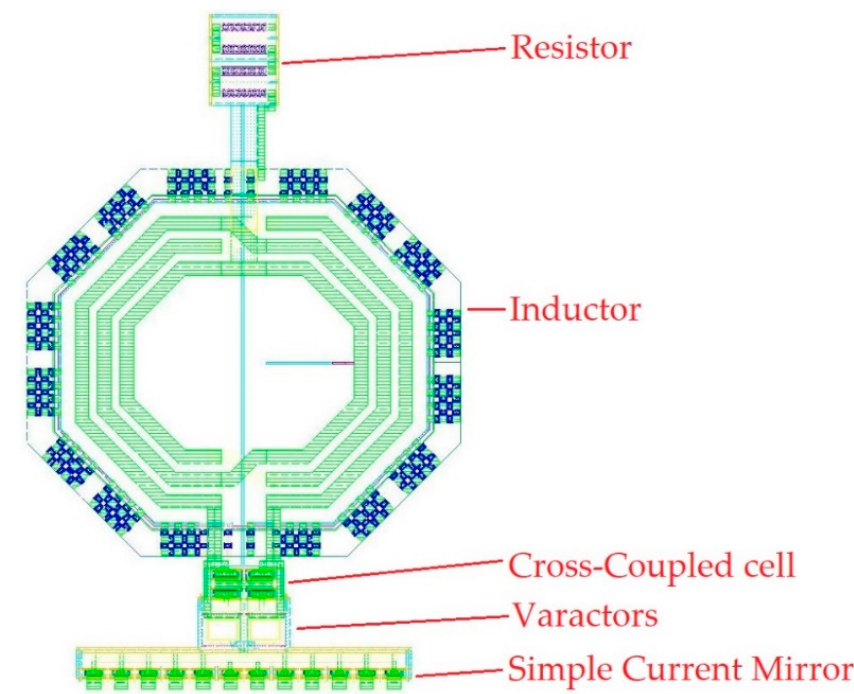
Figure 7. Full custom layout of the LC-tank VCO designed with Cadence Virtuoso [21]. The oscillator is designed to work properly in the temperature range − 55 10% variations of current bias and voltage supply. The total layout area of the proposed LC-VCO is 308 × 198 µ m 2